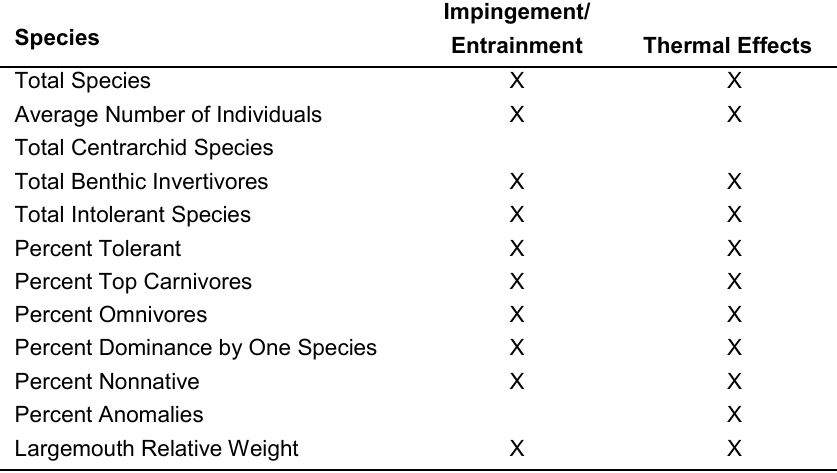
RFAI Metrics Potentially Affected by Impingement/Entrainment and Thermal